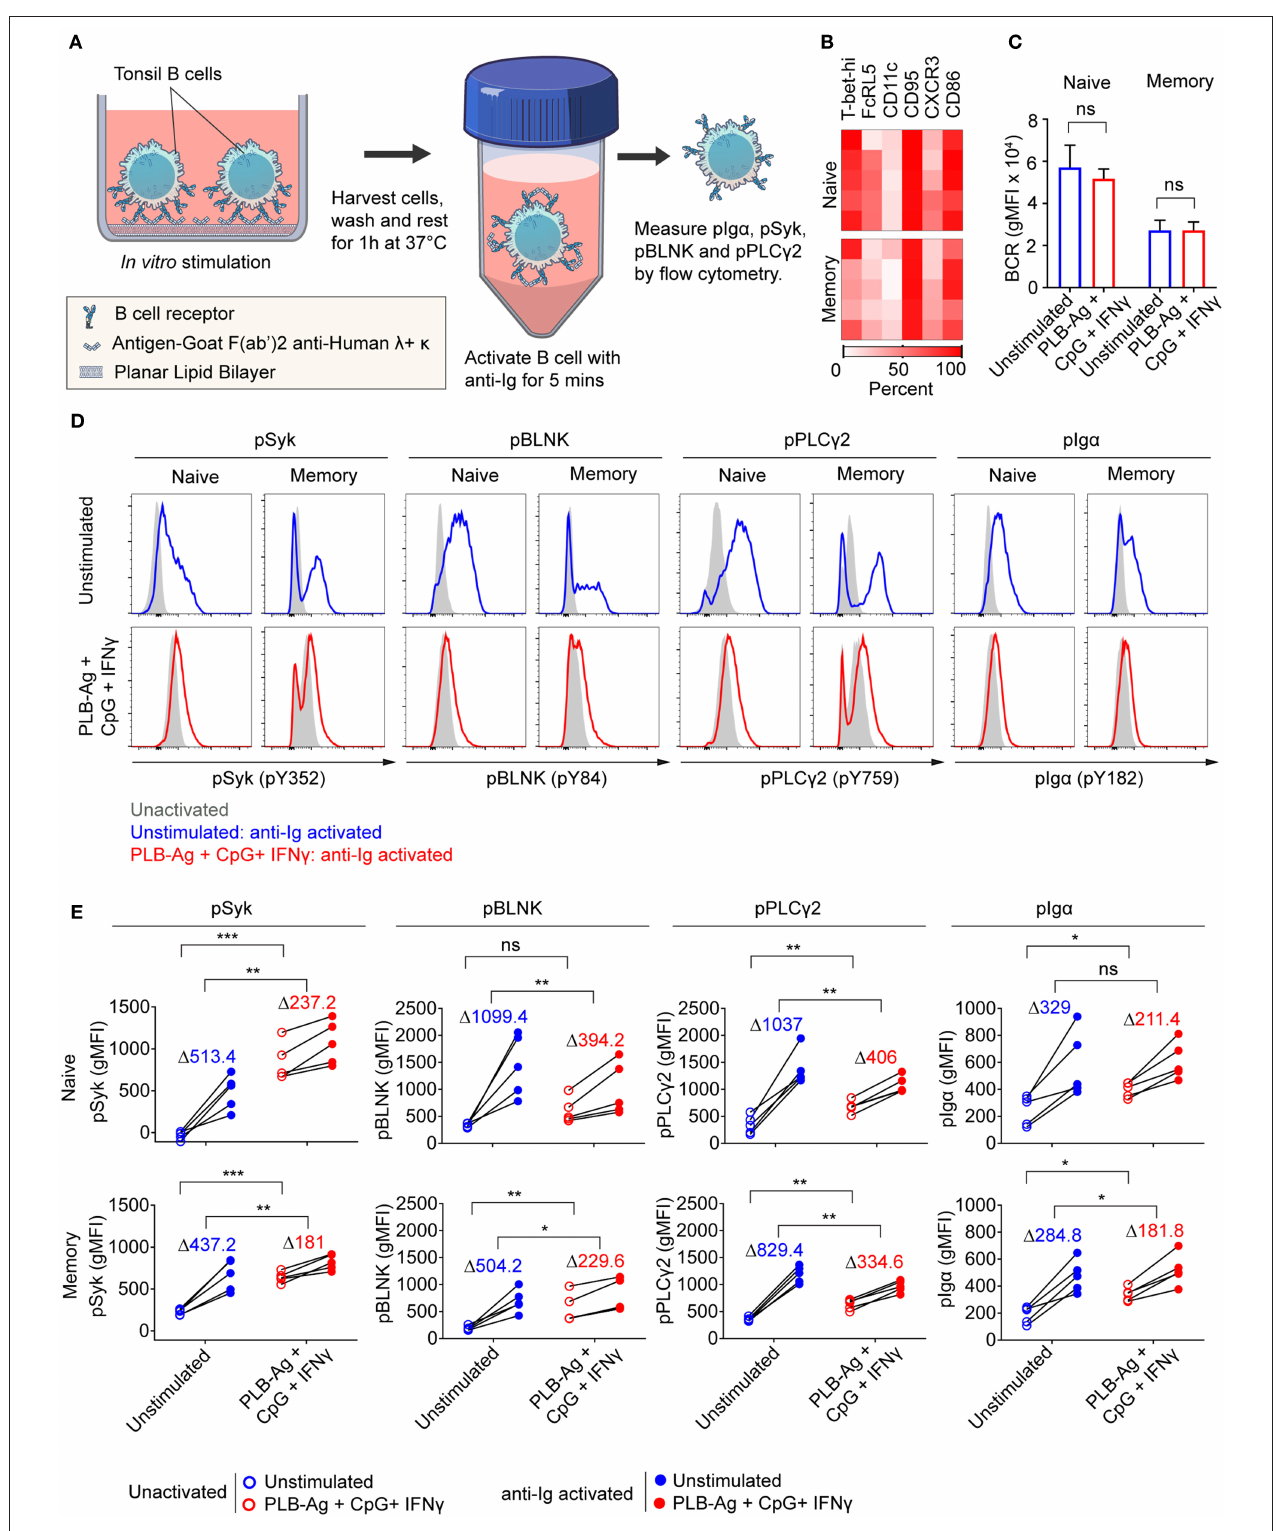
FIGURE 6 | Naïve and memory B cells stimulated in vitro to express T-bet exhibit altered BCR signaling. (A) Schematic representation of the strategy for measuring the response of tonsil B cells stimulated in vitro for 40h with antigen on PLB in the presence of CpG and INF- γ to subsequent BCR crosslinking. Following in vitro culture B cells were harvested, washed and rested for 1h at 37 ◦ C. Cells were activated with soluble F(ab ′ ) 2 antibodies specific for human IgG + IgA + IgM (H + L)